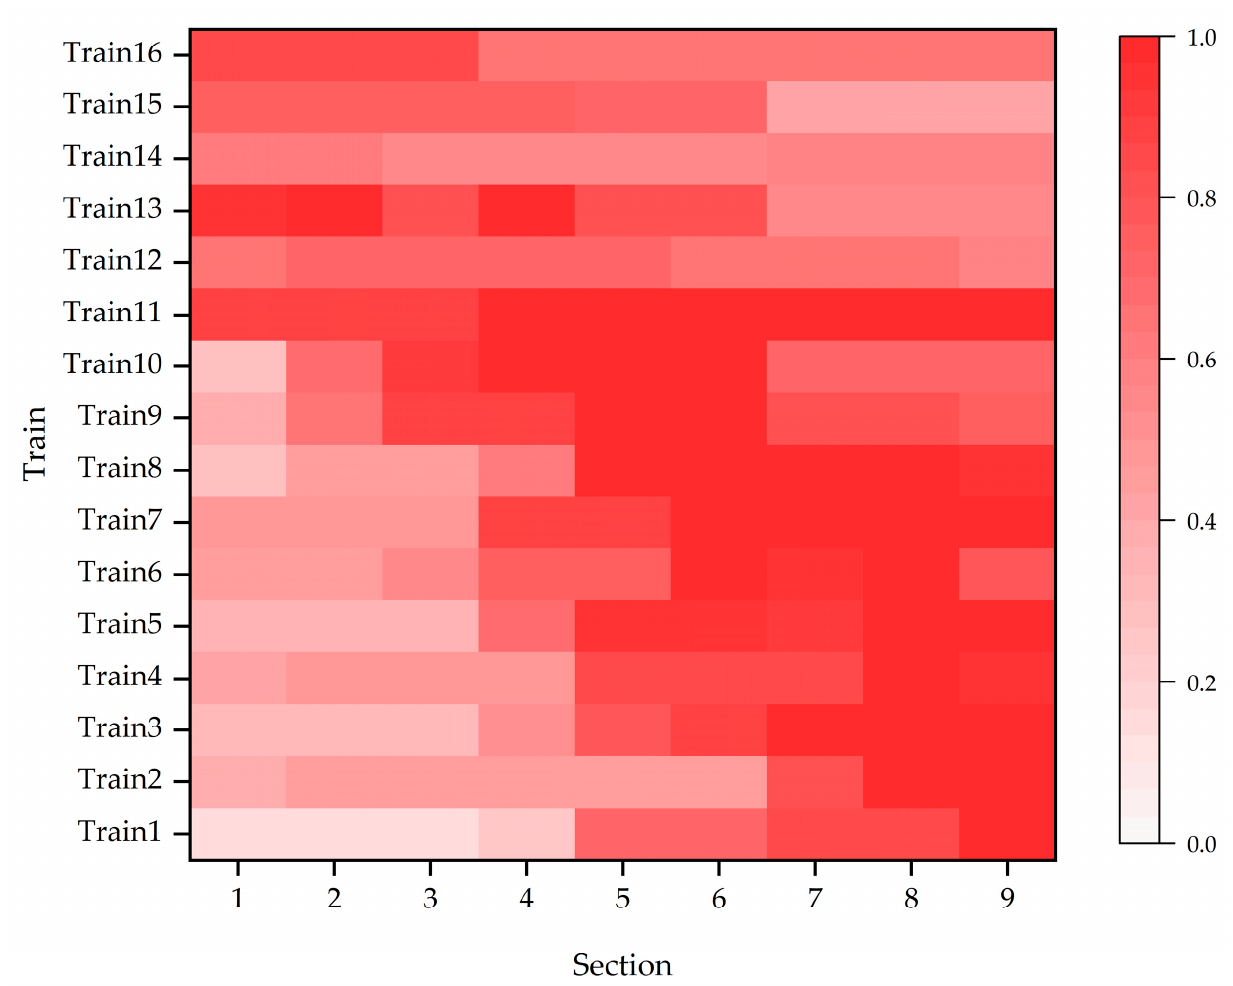
Figure 8. Seat occupancy of each train in the experiment.